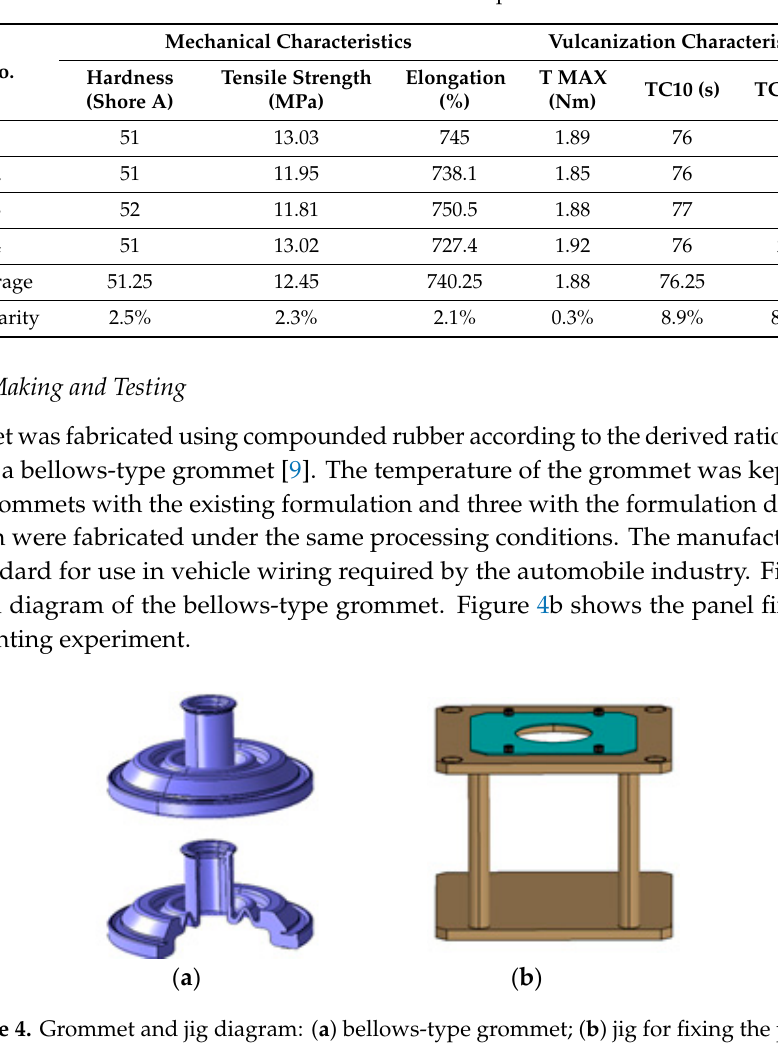
Table 3. Results of validation experiments.